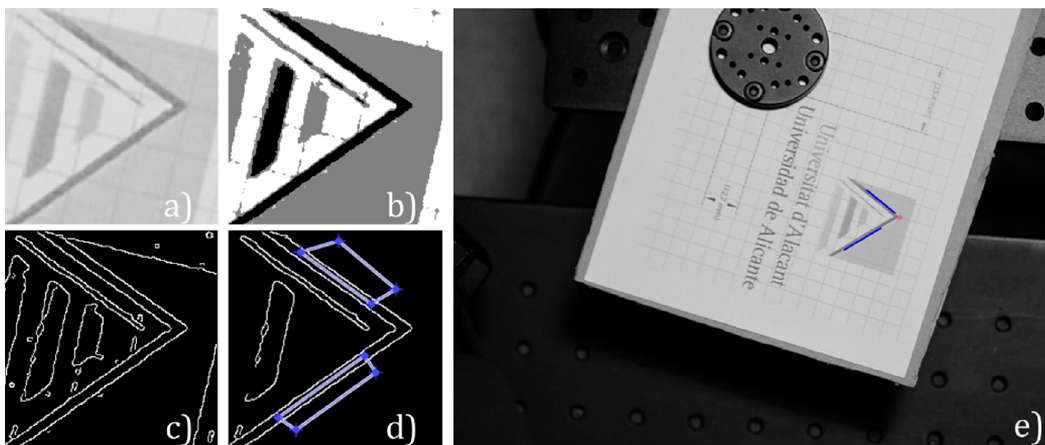
Figure 7. The image of the object fixed to the rotation stage was ( a ) cropped, ( b ) quantized, ( c ) edge extracted, ( d ) and removed of small objects, successively. From the final step, we selected two areas from where the segments were extracted. ( e ) Frame of the recorded video (see Visualization 2) of the object in the rotation stage together with the selected segments in blue and the computed intersection.